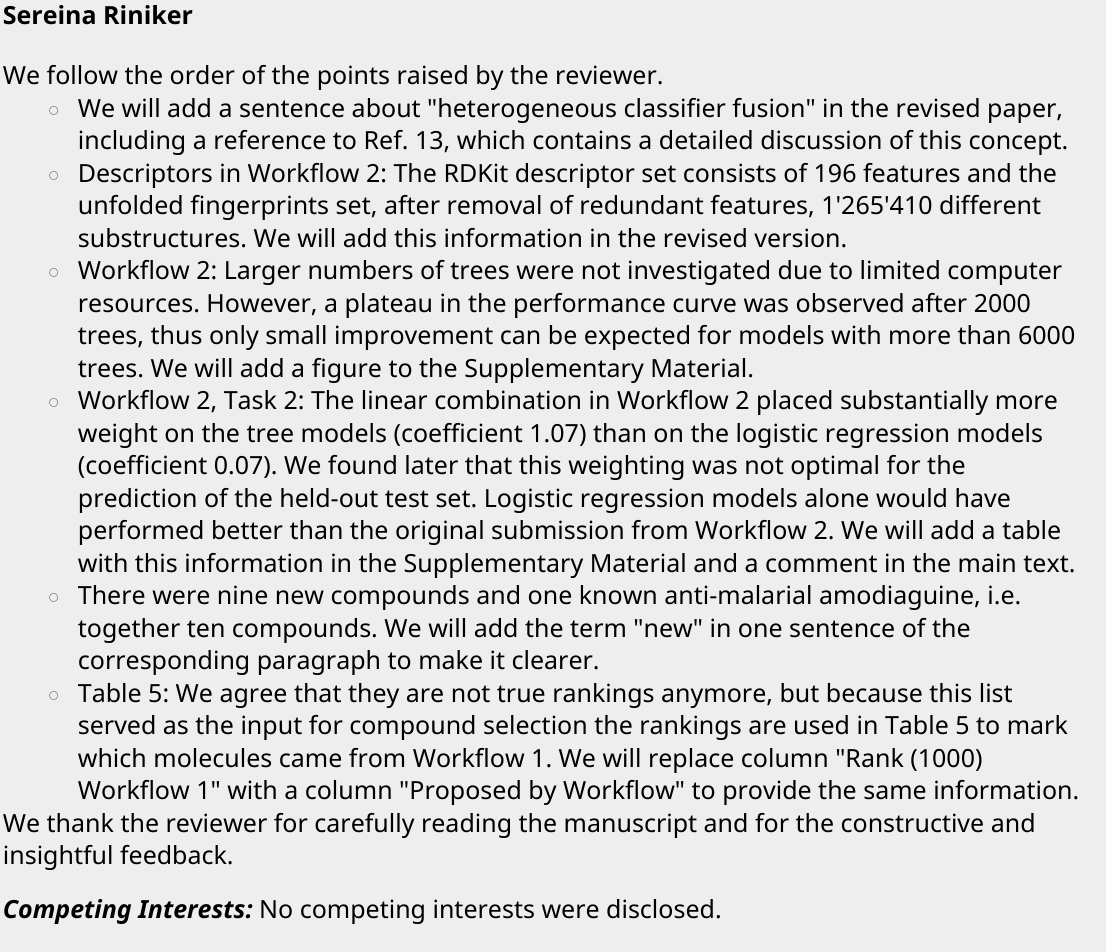
Table 5: We agree that they are not true rankings anymore, but because this list served as the input for compound selection the rankings are used in Table 5 to mark which molecules came from Workflow 1. We will replace column "Rank (1000) Workflow 1" with a column "Proposed by Workflow" to provide the same